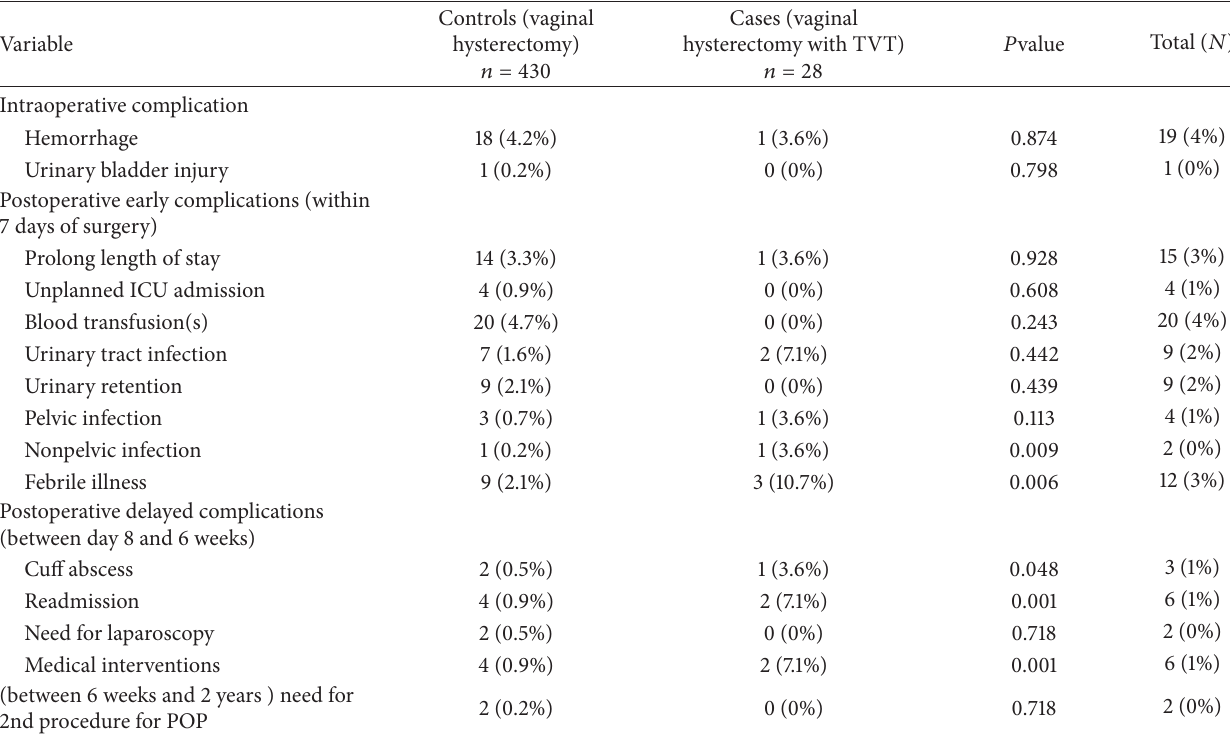
Table 3: Complication of cases (vaginal hysterectomy with TVT) and controls (vaginal hysterectomy).